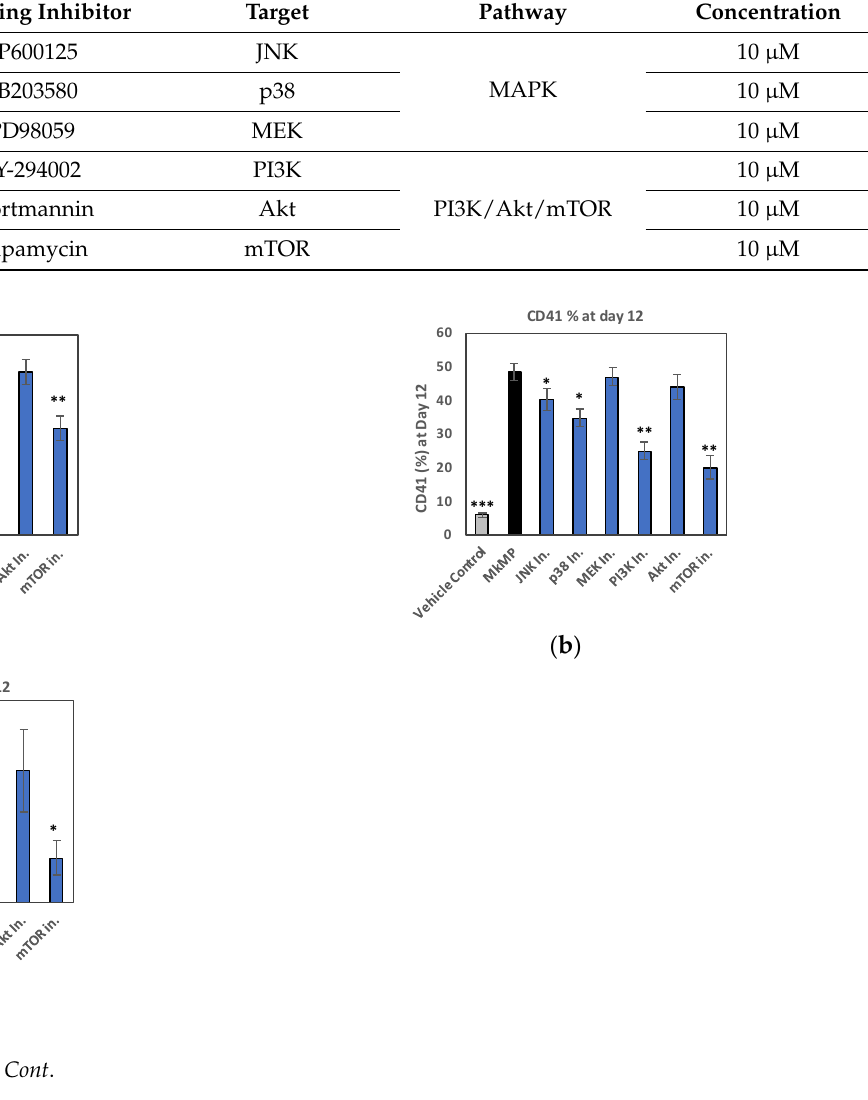
Table 2. List of signaling inhibitors, their targets, and concentrations used.